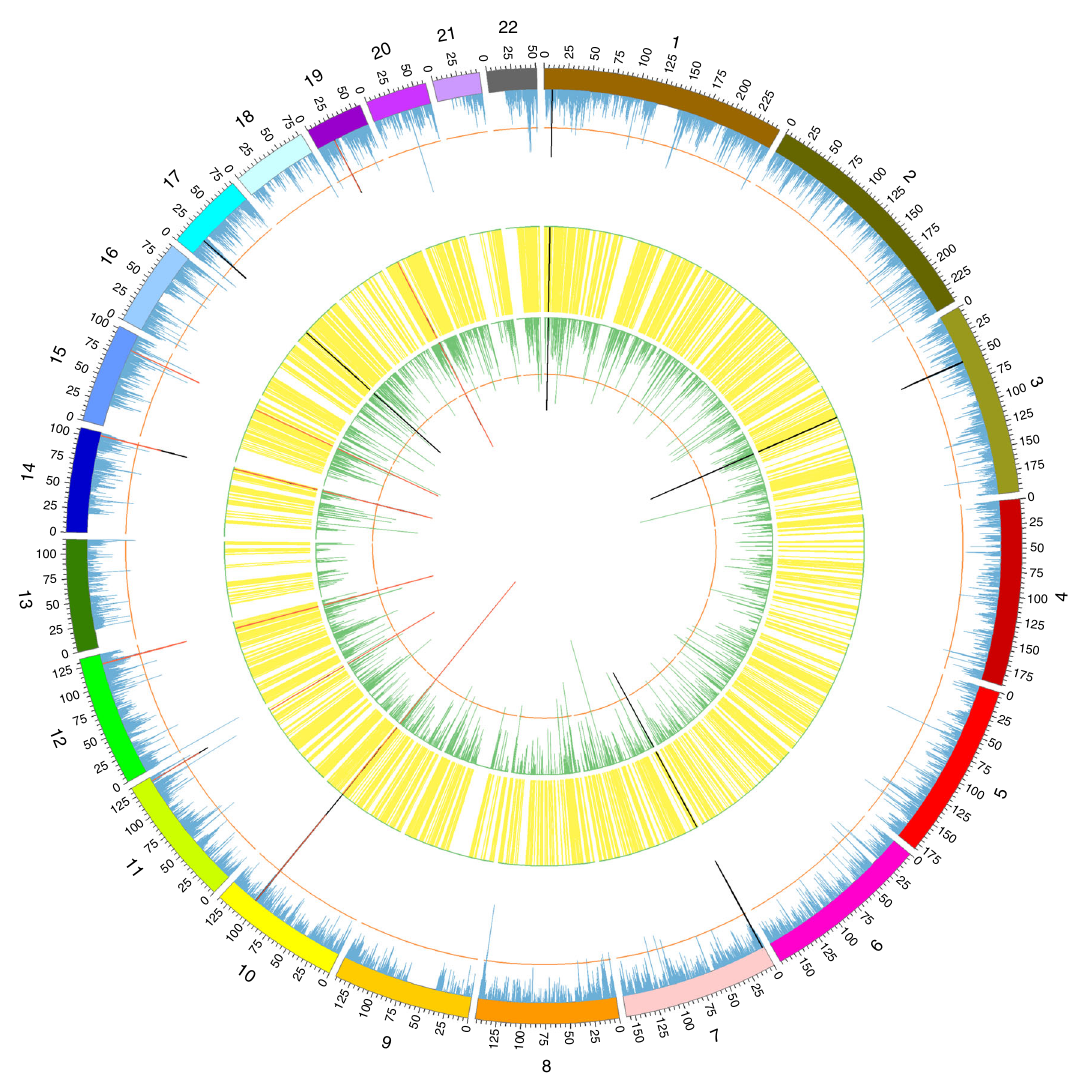
Fig. 3 Pinpointing functional regions for a complex trait with consistent SMR association signals across multi-omics layers. Shown are − log 10 ( P -values) from the SMR tests for schizophrenia against the physical positions of DNAm or gene expression probes. The blue lines (outer ring) represent − log 10 ( P- values) from the SMR tests for associations between DNA methylation and trait, the green lines (inner ring) represent those for the associations between transcripts and trait and the yellow lines (middle ring) represent the signi fi cant associations between methylations and transcripts. The orange circles represent the signi fi cance thresholds of the SMR tests. The black lines are the signi fi cant SMR associations consistent across all three layers, and the red lines highlight the signi fi cant and consistent SMR associations that are not rejected by the HEIDI test. Due to the large scale of the plot, DNAm and genes that are distally associated (e.g. >500 kb and <2 Mb) appear to be closely located in the fi